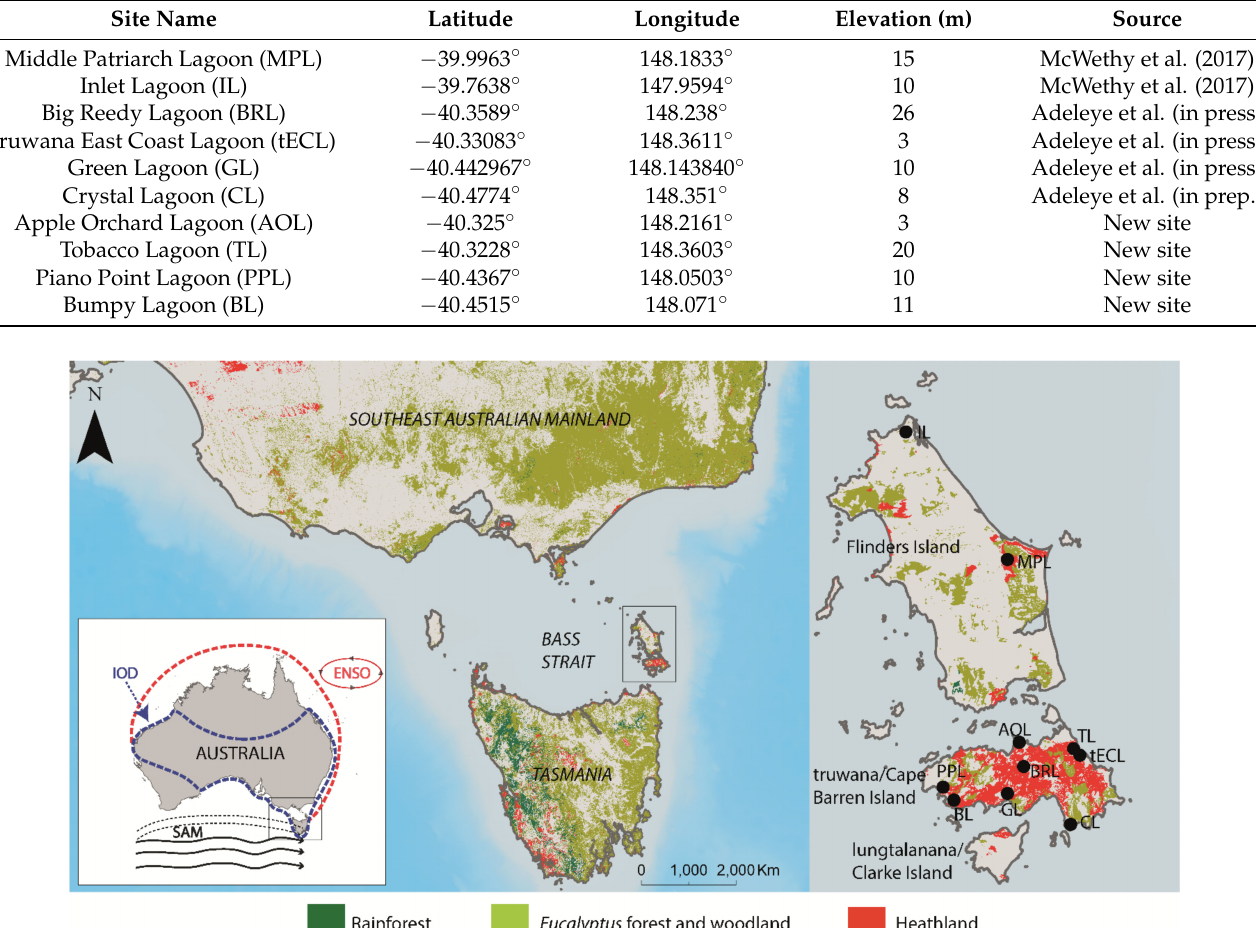
Table 1. Site information of charcoal records from the Furneaux Group islands, Bass Strait.